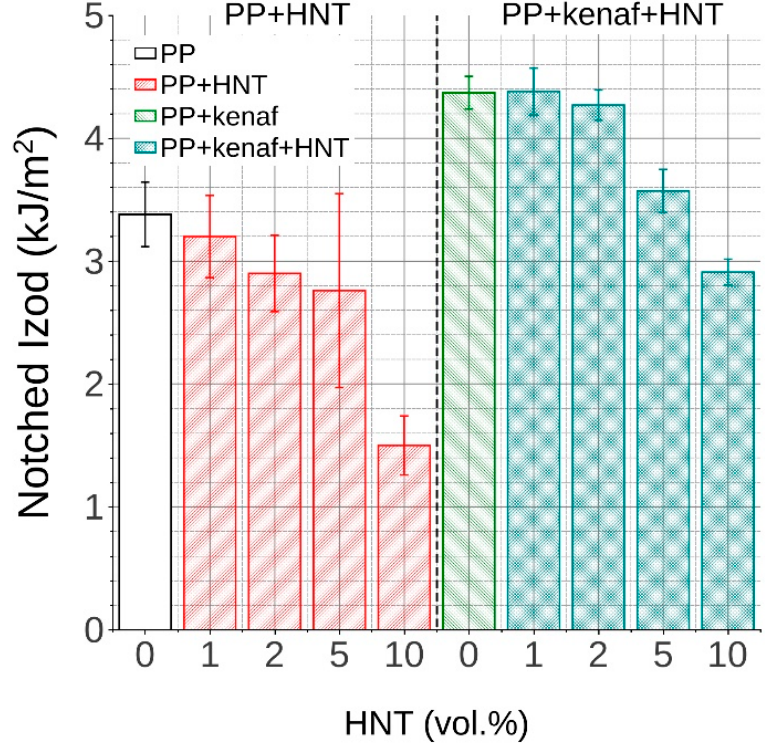
Figure 6. Izod impact strength of PP, PP/HNTs NCs, PP/kenaf, and PP/kenaf/HNTs hybrid NCs reinforced with different volumetric contents of HNTs.